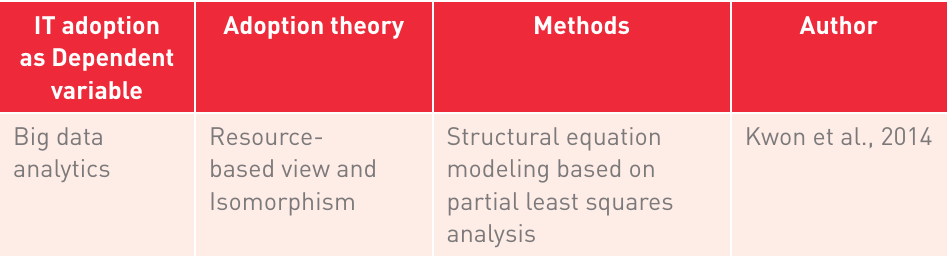
Big data analytics research published IT adoption as Dependent